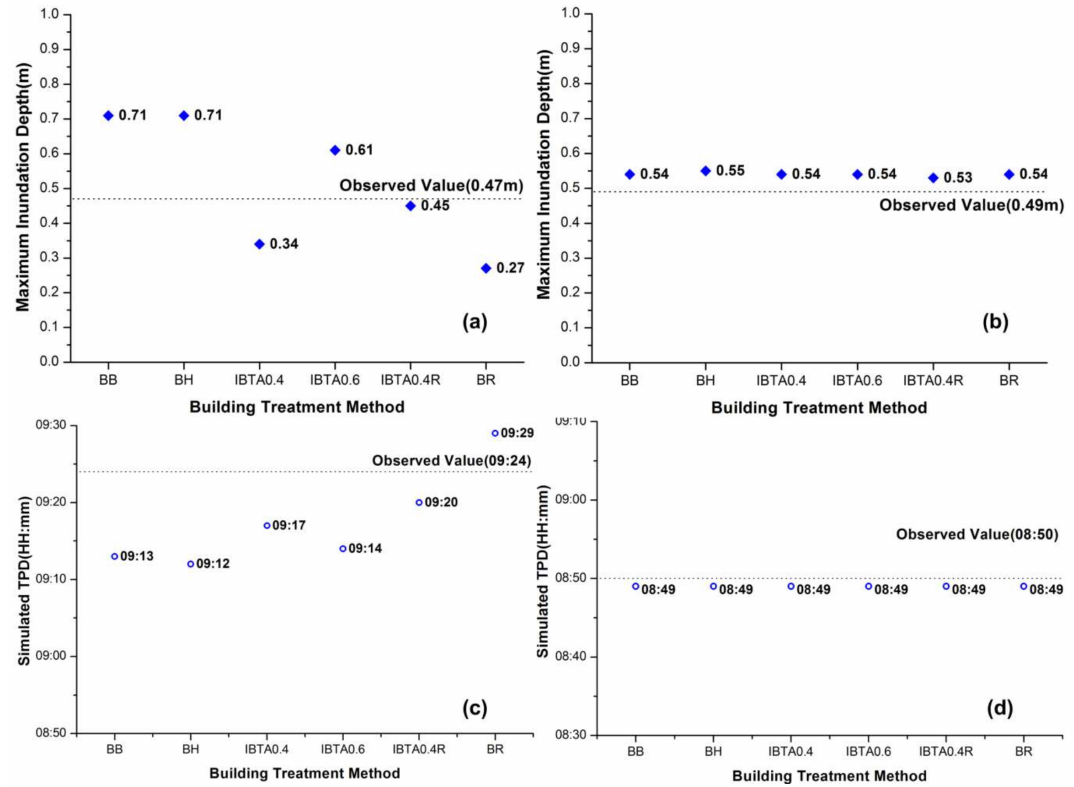
Figure 17. Comparisons of simulations produced by different modeling scenarios and the observations at four single monitoring points: ( a ) maximum inundation depth at Point D; ( b ) maximum inundation depth at Point I; ( c ) TPD at Point A; and ( d ) TPD at Point